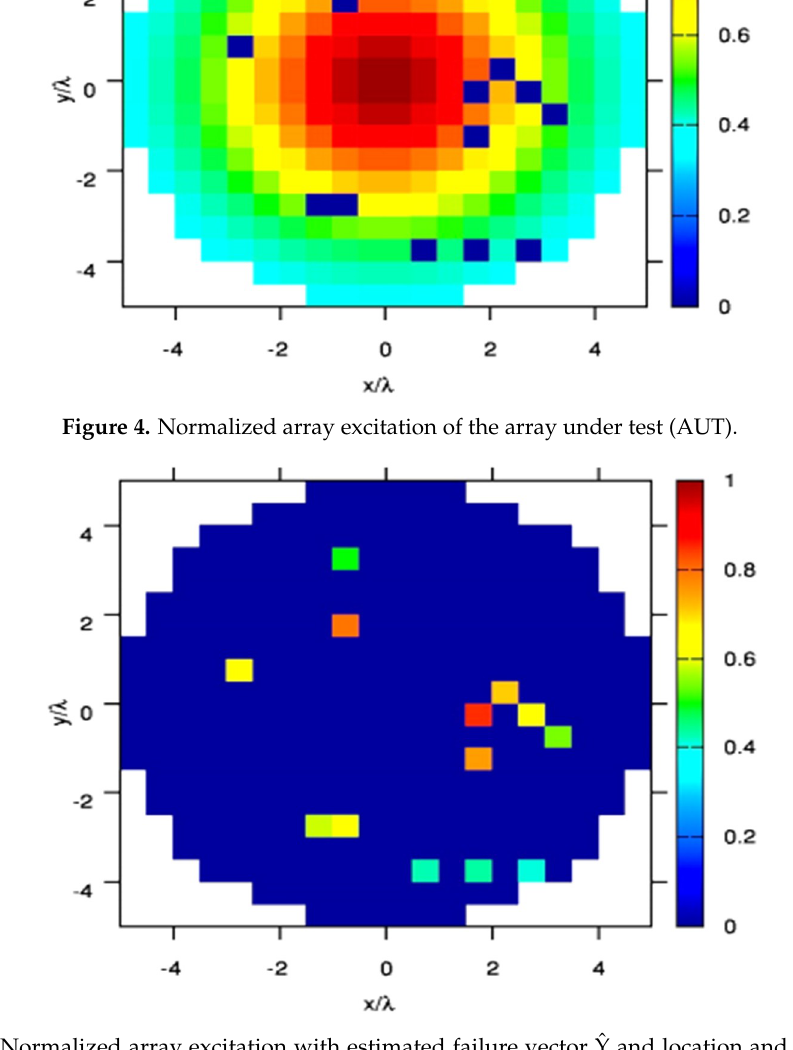
Figure 5. Normalized array excitation with estimated failure vector ˆ Υ and location and amplitude of entries.